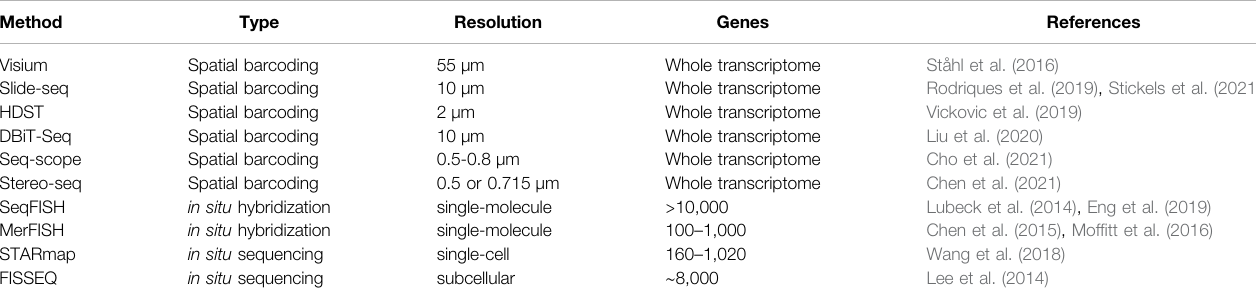
TABLE 2 | Current experimental methods for spatial transcriptomic pro fi